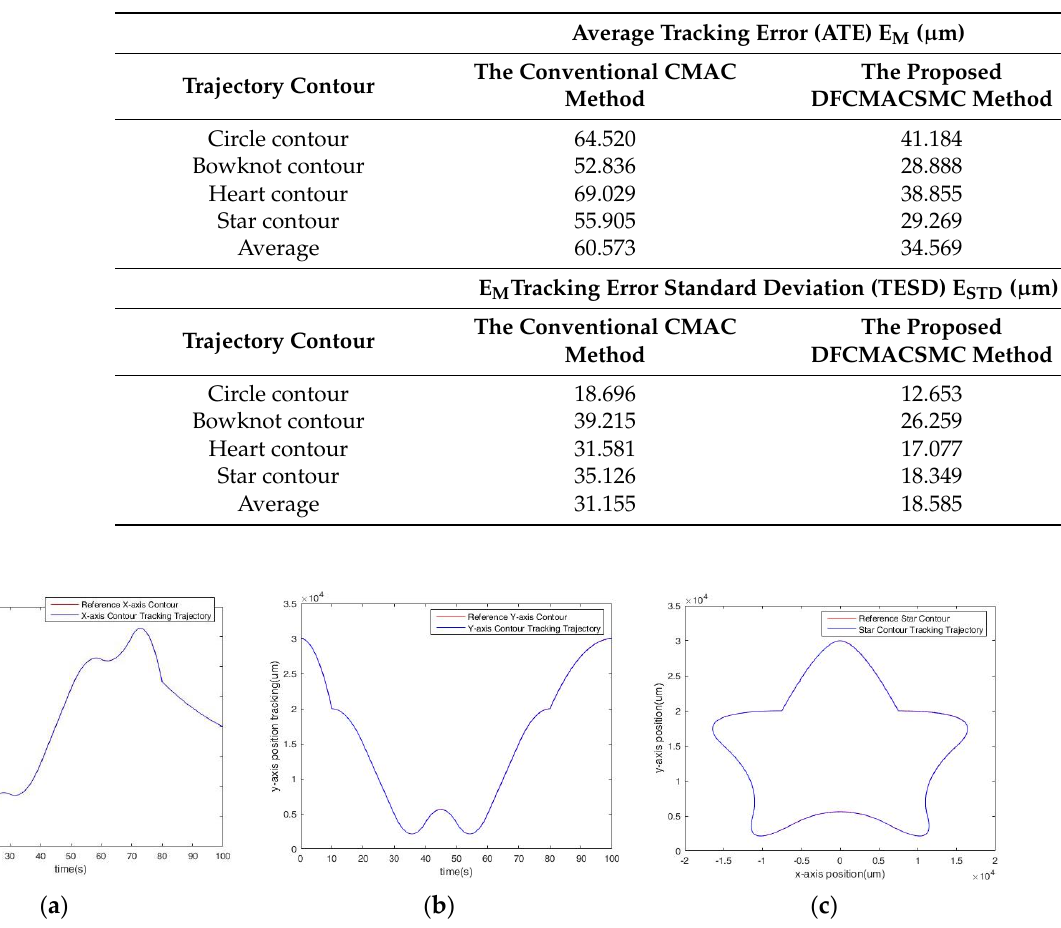
Table 3. The experimental results showing contour tracking errors.